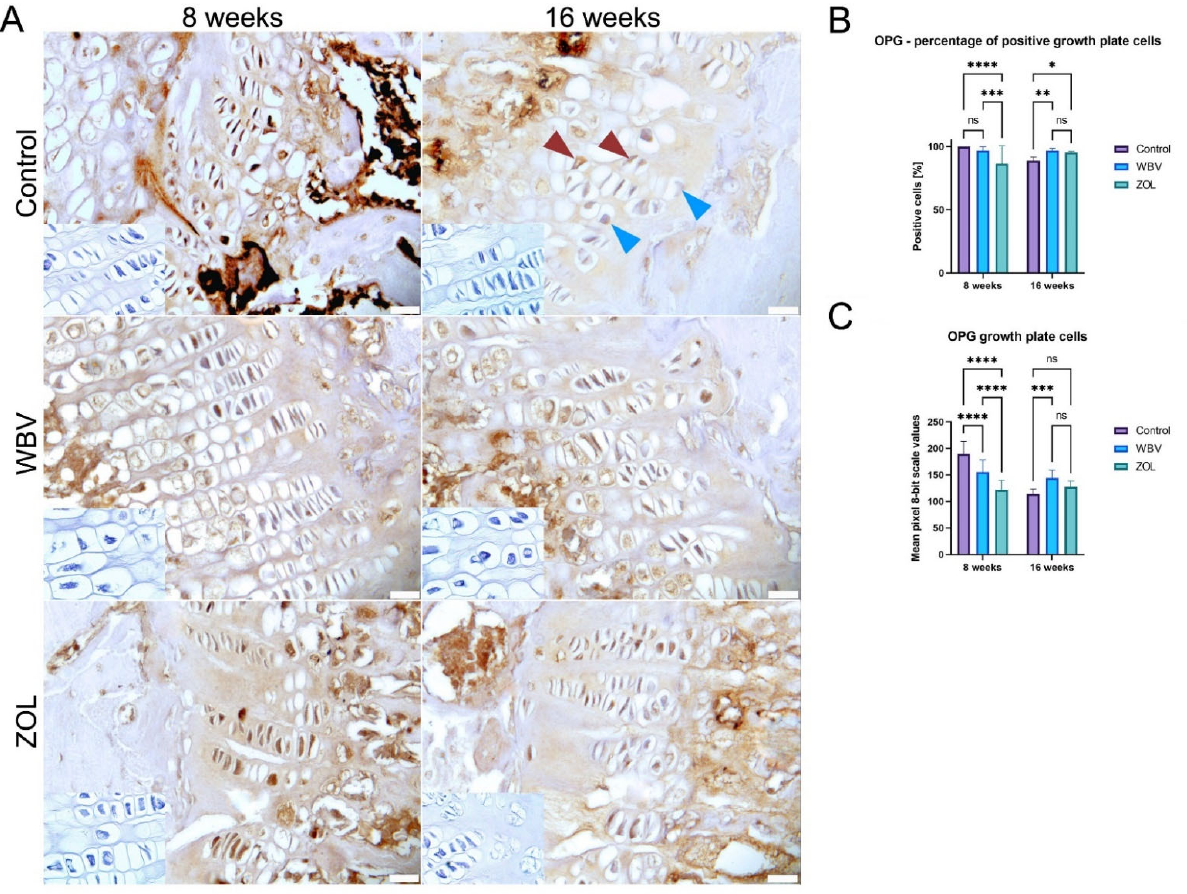
Figure 6. The immunohistochemical reaction for osteoprotegerin (OPG) in the growth plate of femora of rats subjected to obesity and immobility: ( A ) Representative images of the immunohistochemical reactions for OPG. Brown and blue arrowheads indicate examples of positive and negative reaction cells, respectively. Insets show control immunohistochemical staining without primary antibody. All scale bars represent 50 μ m; bar graphs show ( B ) percentage of cells showing positive reaction to OPG, and ( C ) the intensity of immunoexpression of OPG in the growth plate cells measured by the 8 ‐ bit grayscale pixel brightness value (the higher the pixel value, the higher the intensity of the immunohistochemical reaction). Data are mean values ± SD from n = 6 rats. Control—the control group included rats subjected to obesity and immobility not treated with WBV or ZOL; WBV—the WBV group included rats subjected to obesity and immobility with whole ‐ body vibration treatment (30 min, 5 days per week); ZOL —the ZOL group included rats subjected to obesity and immobility and injected intramuscularly with zoledronic acid at a dose of 0.025 mg/kg body weight every 4 weeks. Statistical significance: ns—not significant; * p < 0.05; ** p < 0.01; *** p < 0.001; **** p < 0.0001 (Tukey’s HSD test or Kruskal–Wallis H test).